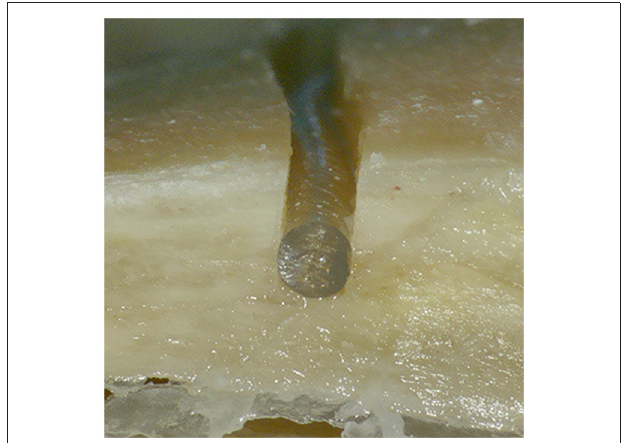
FIGURE 7 | Cross section of the resulting channel with an embedded electrode lead cut for visualization. The electrode lead lies completely below the surface of the temporal bone and is held in place through the slight press fit between the channel